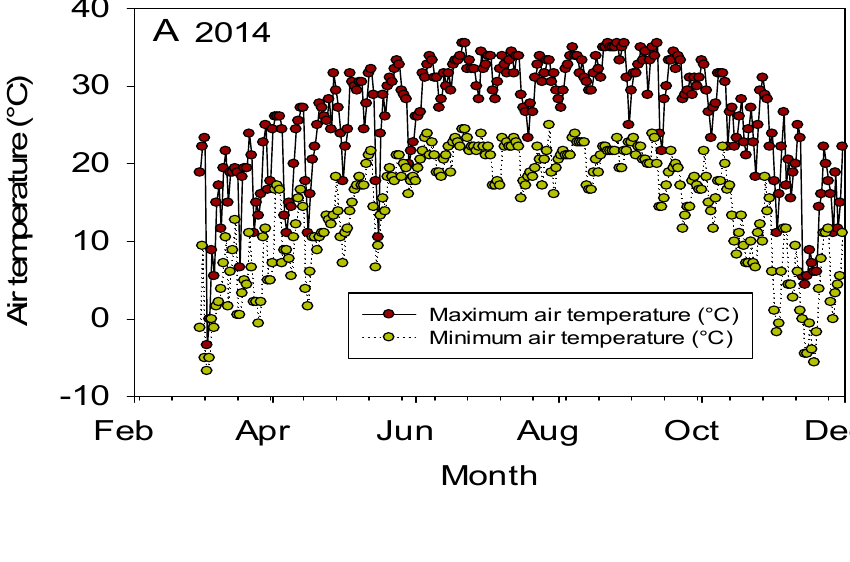
ent levels, including protein, oil, and fatty acids profiles [41–48]. The higher oil in the Uz- bek line and DP 5690 wild type than DP 5690 CRL could be partially due to the fact that leaf shape affected oil content and yield. Unpublished data showed that Uzbek CRL and DP 5690 wild type had larger seeds than DP 5690 CRL, and the highest 100-seed weight was recorded in the Uzbek CRL line (12.04 g) compared with the DP 5690 wild type (10.43 g) and DP 5690 CRL (9.48 g). The Uzbek CRL line had the largest boll, followed by the DP 5690 wild type, and then DP 5690 CRL, which had the smallest size. Figure 2 shows the size of the three lines in the field, and the bolls for both Uzbek curly leaf and DP 5690 curly leaf.